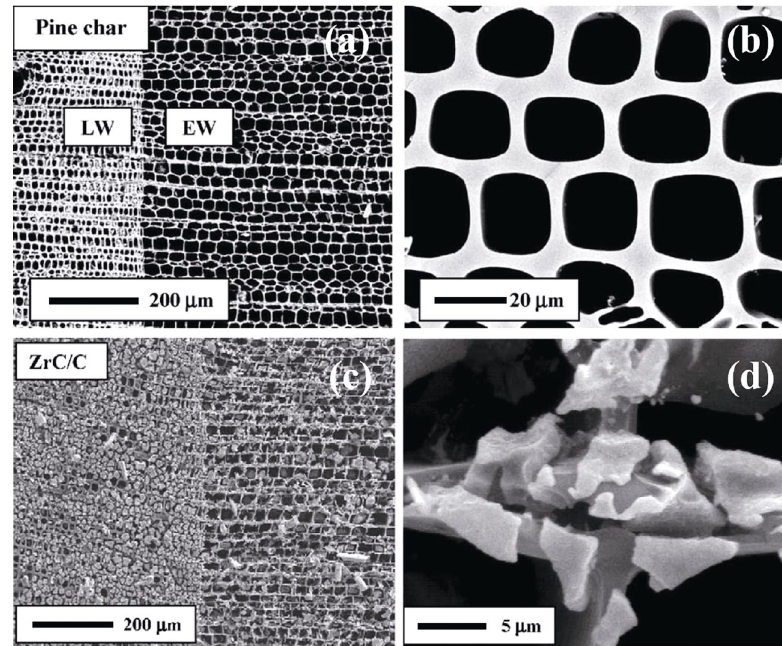
Fig. 5 SEM images of the pine wood char with (a) low and (b) high magnifications. SEM images of the wood derived porous ZrC/C with (c) low and (d) high magnifications [53]. Reproduced with permission from Ref. [53], © Elsevier Ltd.